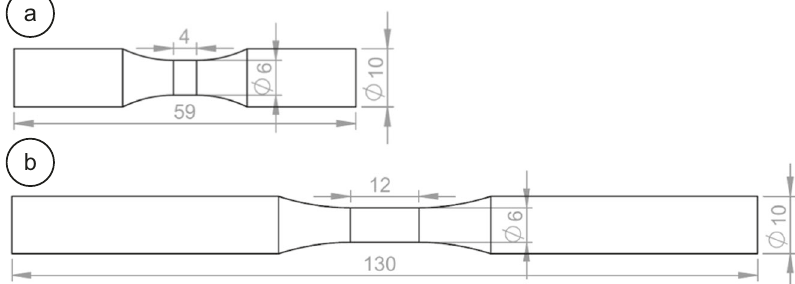
Fig. 16 Specimen geometries for fatigue testing. a EBM iron b HR